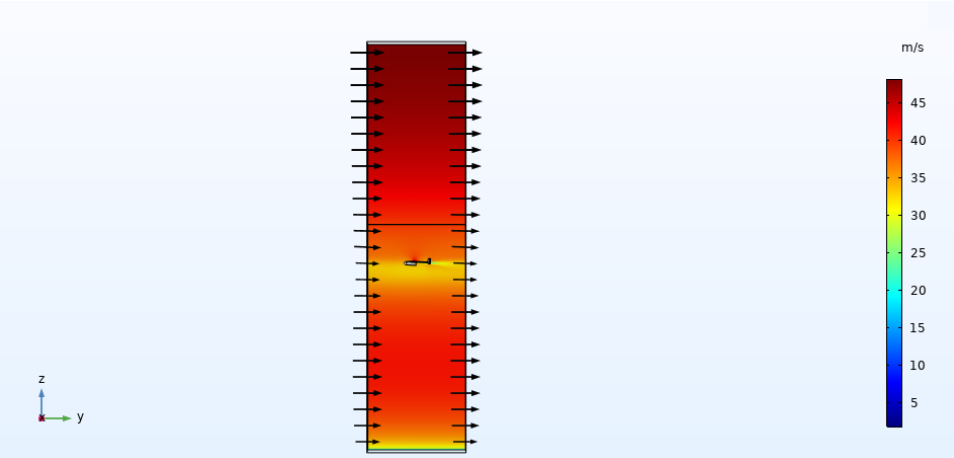
Figure 5. Maximum wind flow in ms − 1 at 2000m of altitude and 3° AOA.